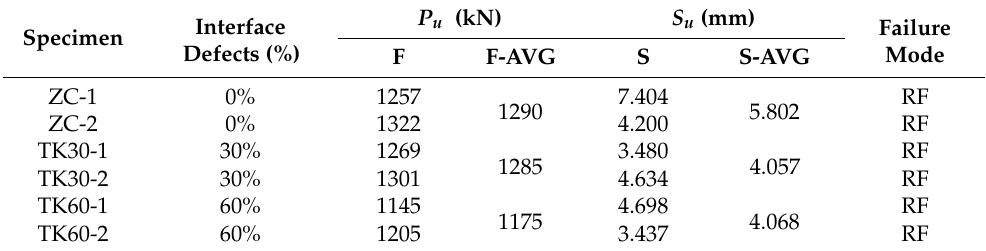
Table 3. Failure results of push-out tests.